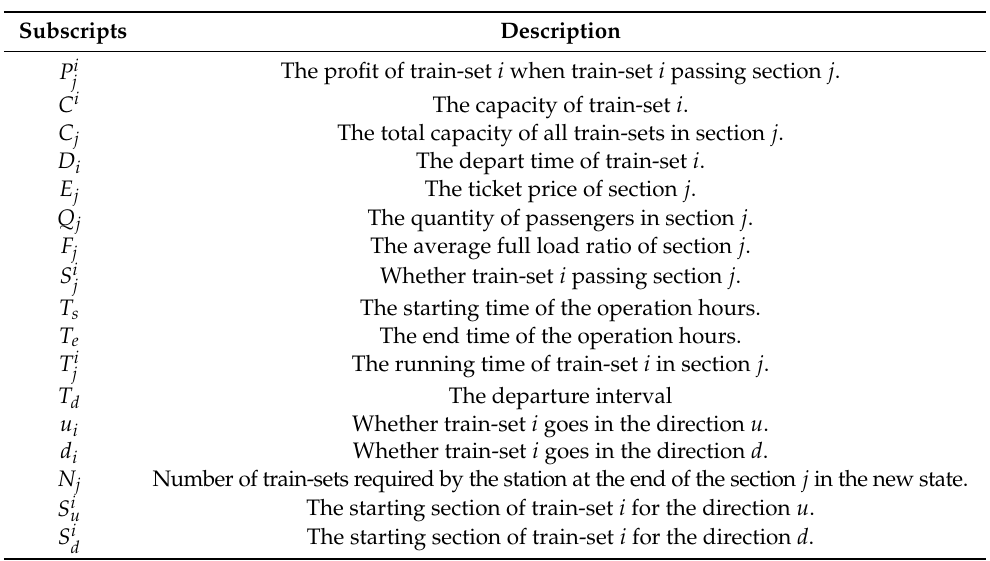
Table 2. Description of the